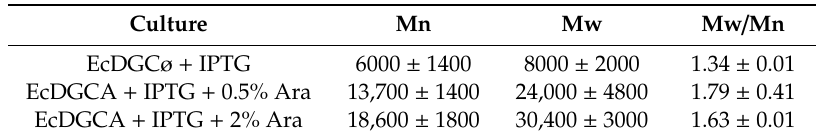
Table 1. HPSEC-MALS analysis of chondbiuronan and chondroitin in this work. Error is the mean of two independent